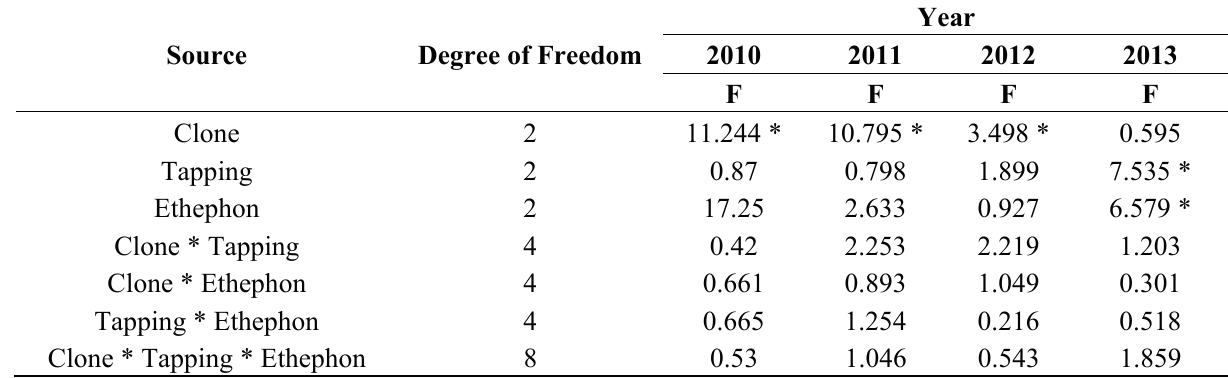
Table 1. Interaction between the effect of genotype, tapping, ethephon and the combination of factors during 4 years. The ANOVA test and the Bonferroni test were used in the statistical analyses ( p < 0.05). Significant data was marked with an asterisk.